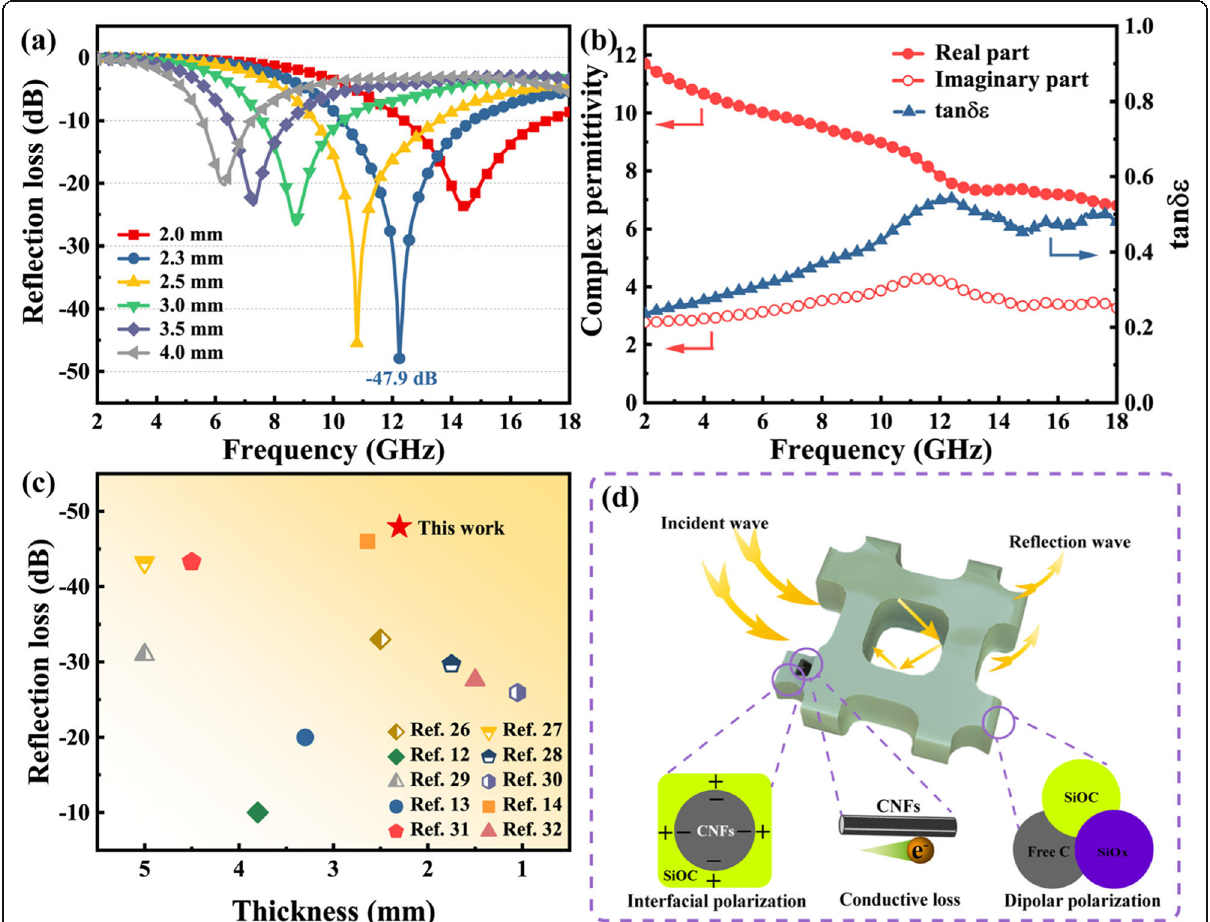
Fig. 5 The MA properties of HPSCs. a The RL curves. b The complex permittivity and tangent loss curves. c RL min versus thickness of similar Si- based ceramics absorbers. d The schematic illustration of MA